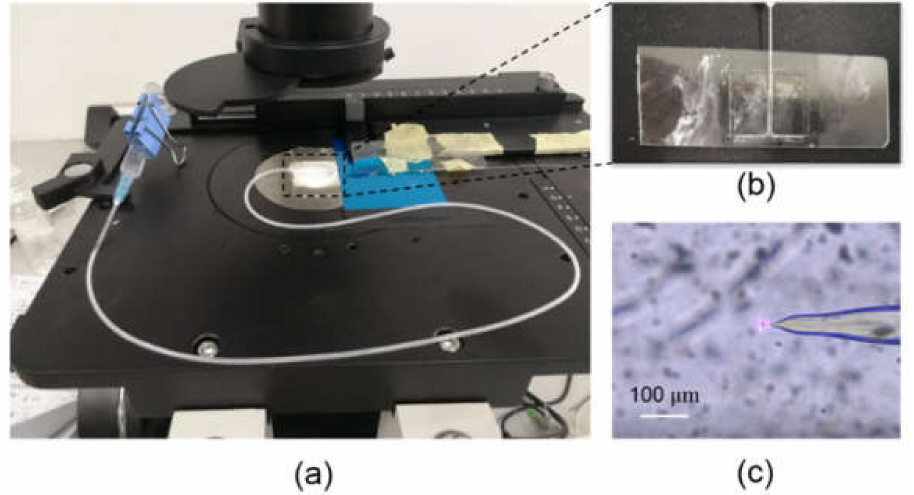
Figure 7. ( a ) Experimental setup for the tapered optical fiber trap in the microchannel chip; ( b ) the microchannel chip in which the tapered fiber is inserted; ( c ) the end tip of the tapered fiber with a polystyrene sphere being trapped at the